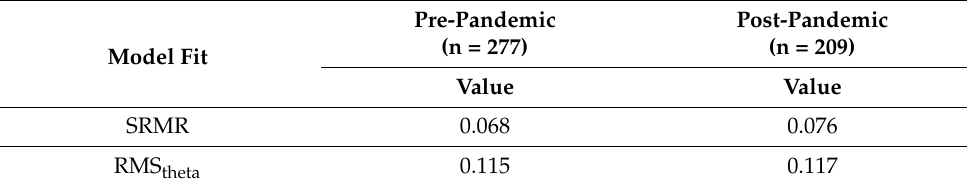
Table 12. Model fit